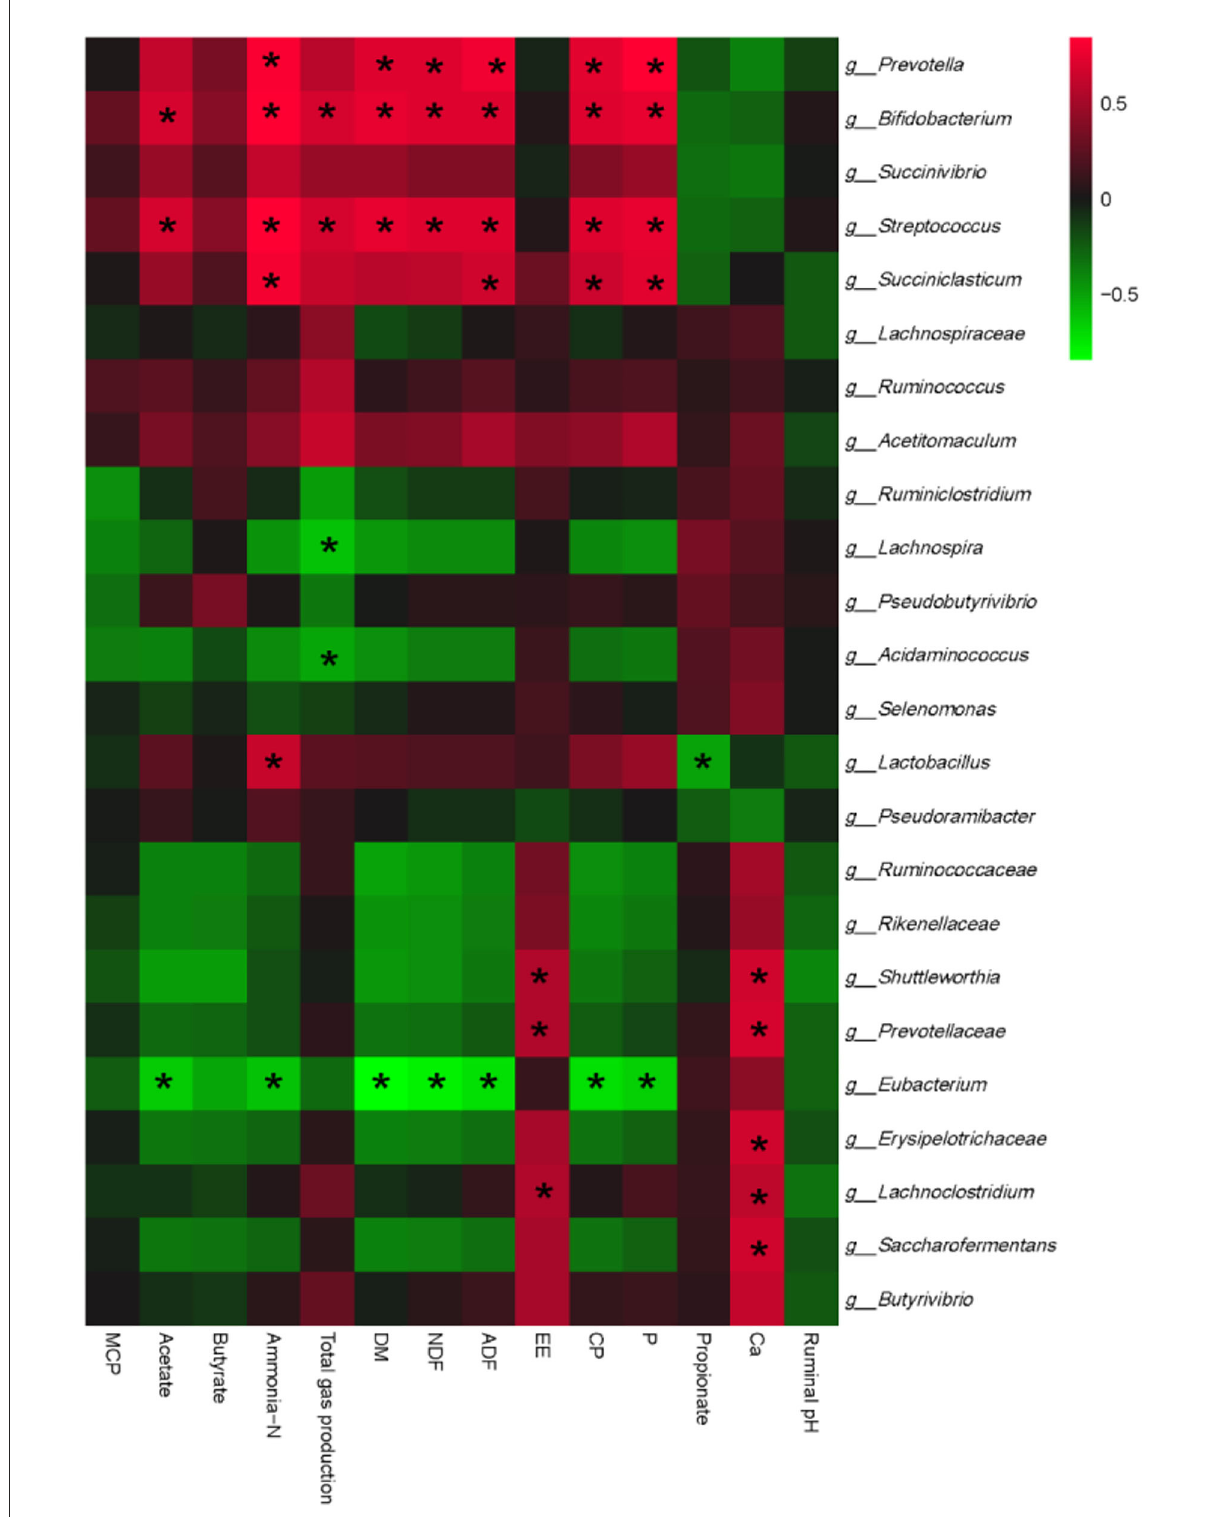
FIGURE2 Correlation analyses between ruminal fermentation parameters, rumen nutritional degradability, and relative abundances of ruminal bacteria at the genus level. The red color represents a positive correlation, while the green color represents a negative correlation. “*” means a significant correlation (|r| > 0.55, P < 0.05). DM, dry matter; NDF, neutral detergent fiber; ADF, acid detergent fiber; EE, ether extracts; CP, crude protein; MCP, microbial